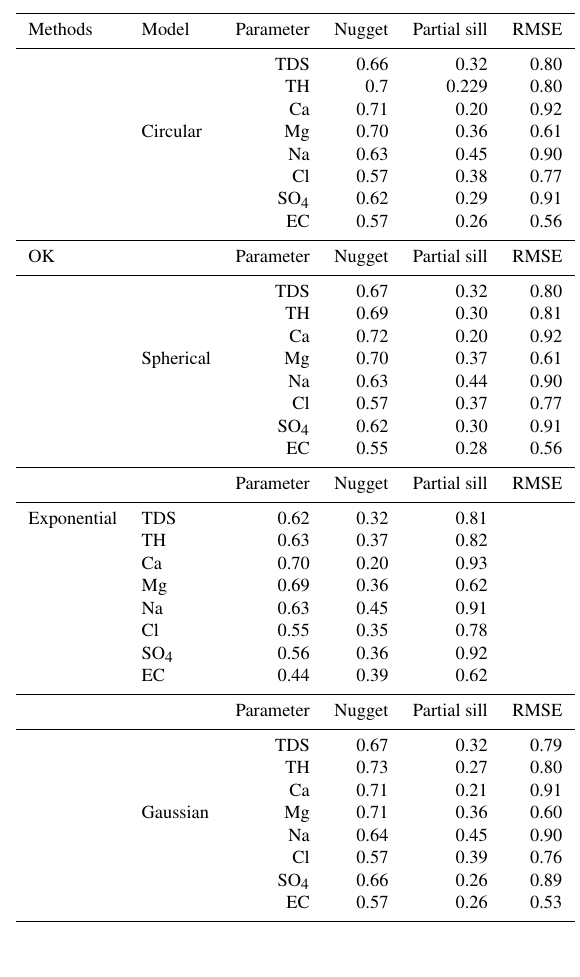
Table 4. Sampling nugget, partial sill, and RMSE of the different interpolated methods for predicted drinking water quality based on content of inorganic components using multiple linear regression